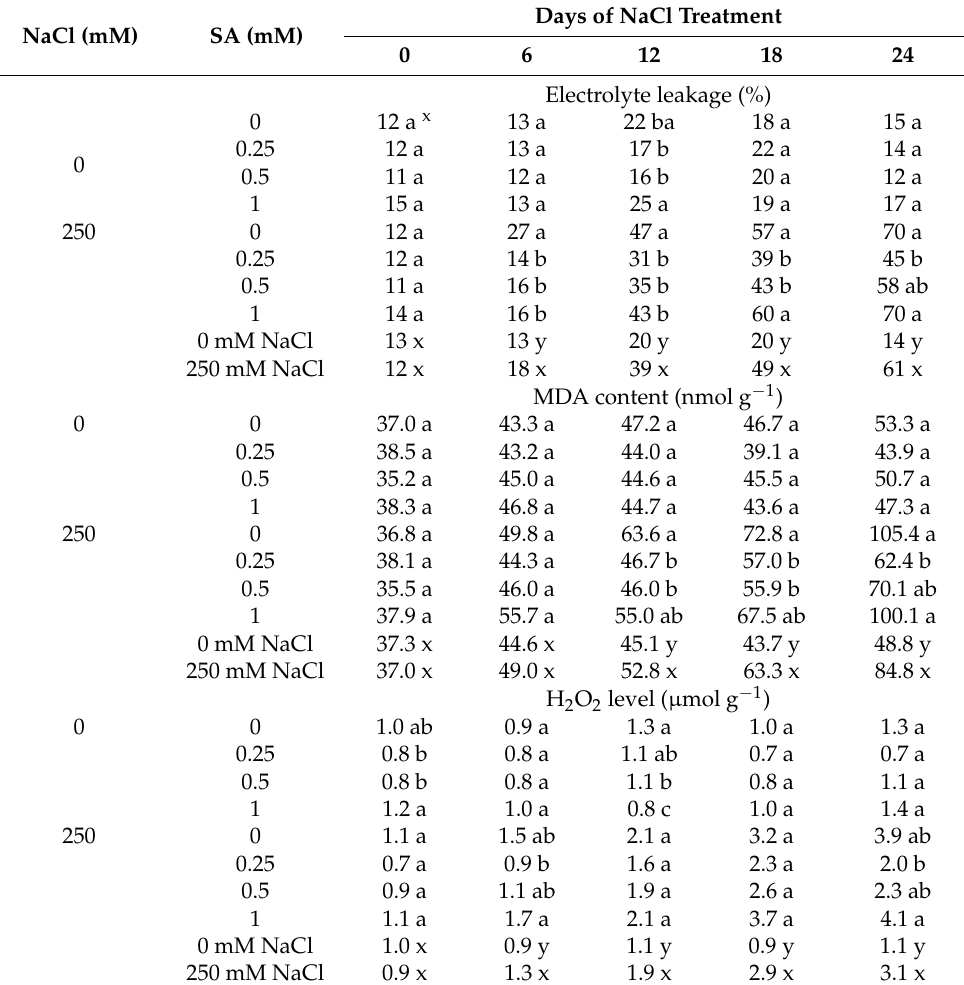
Table 2. Effect of salicylic acid on malondialdehyde (MDA) content, electrolyte leakage, and H 2 O 2 levels of perennial ryegrass under two salt